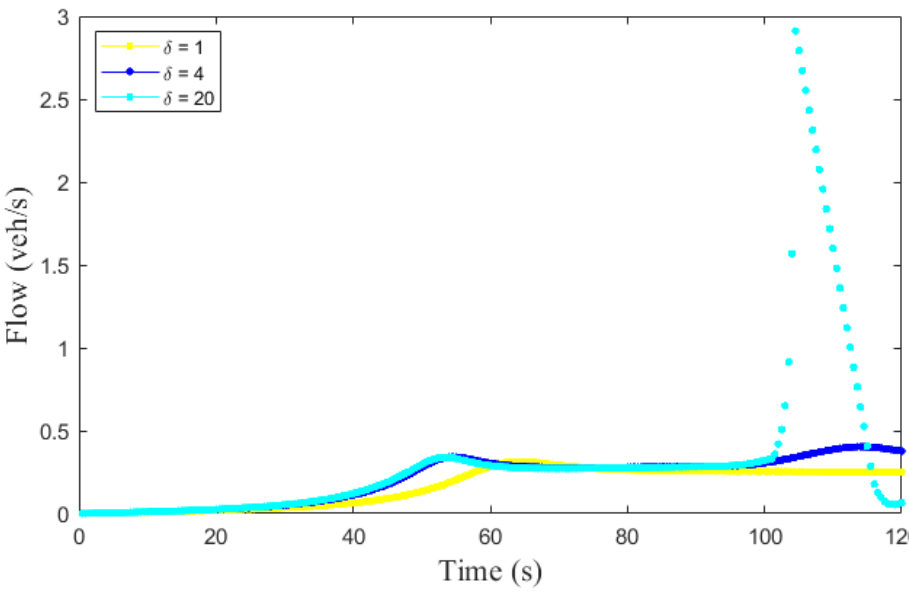
Figure 6. Traffic flow evolution over time with the ID model over an 800 m circular road.